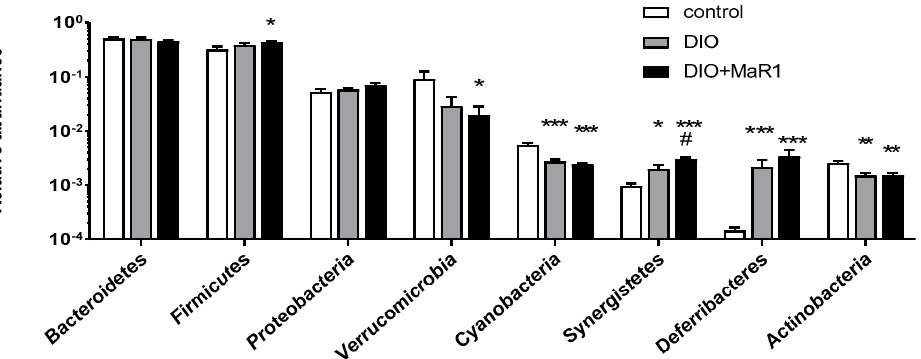
Figure 3. Relative abundance of major phyla in gut microbiota of the control and the DIO mice treated, or not treated, by oral gavage with MaR1 (50 µ g / kg / day) for 10 days. Data are expressed as mean ± SE ( n = 7–8). * p < 0.05, ** p < 0.01, *** p < 0.001 vs. control and # p < 0.05 vs.